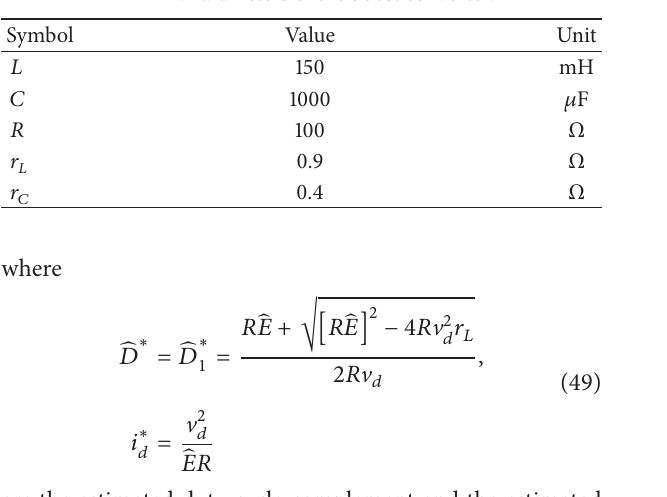
Table 1: Parameters of the boost converter.